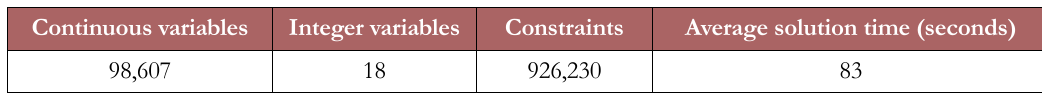
Table 4. Model statistics and computational